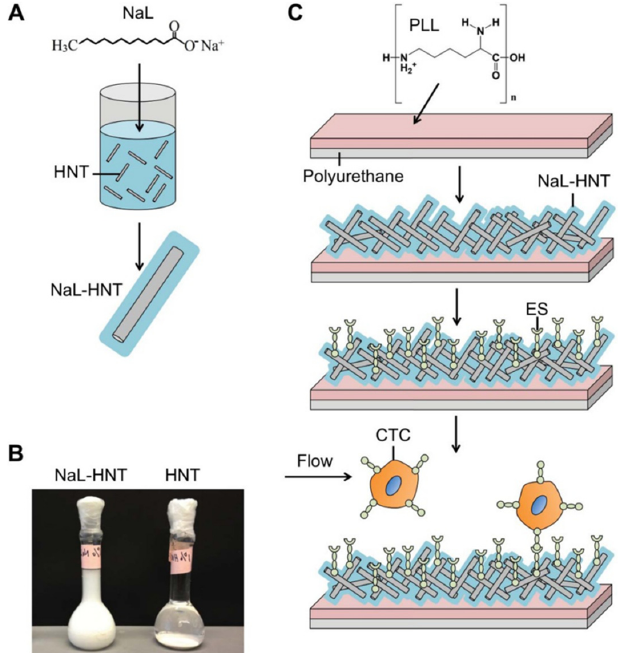
Figure 4. Development of surfactant-nanotube complexes to fabricate nanostructured biomaterial surfaces for flow-based tumor cell capture assays. ( A ) Mixing and adsorption of sodium dodecanoate (NaL) surfactant to halloysite nanotubes (HNT) to create surfactant-nanotube complexes (NaL-HNT). ( B ) Stability of NaL-HNT and HNT dispersions (1.1 wt %) 24-h postmixing and adsorption. ( C ) Fabrication of nanostructured biomaterial surfaces. Polyurethane (PU) flow device surfaces coated with poly-l-lysine (PLL) to immobilize NaL-HNT and HNT. E-selectin (ES) is then adsorbed to HNT-coated surfaces, and tumor cells are perfused over surfaces at physiologically relevant flow